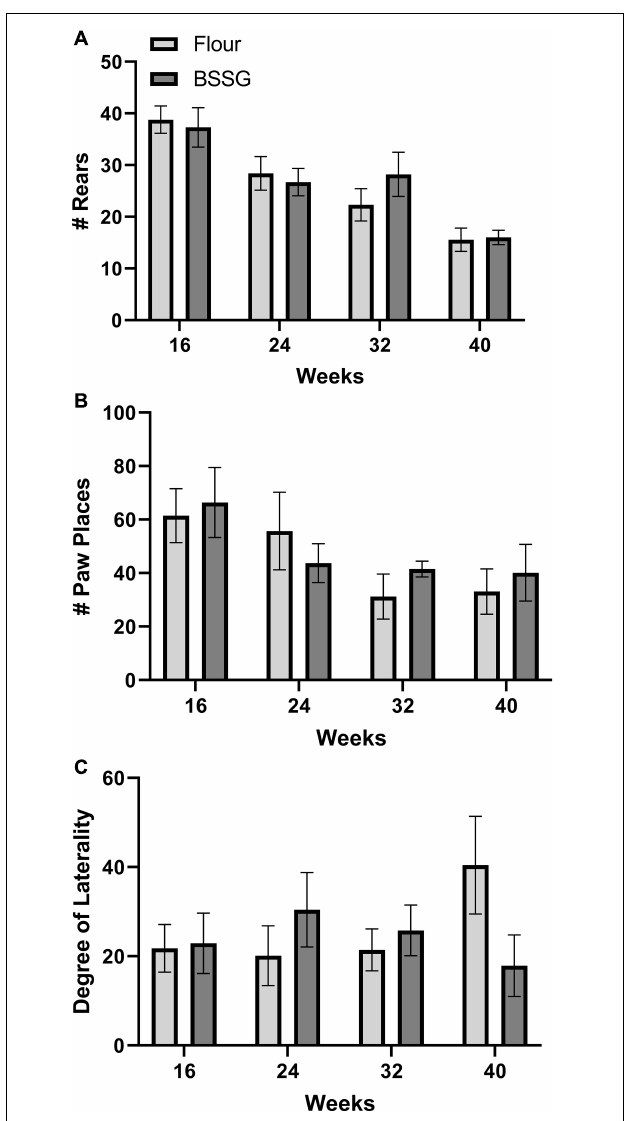
FIGURE 5 | Cylinder test outcomes. (A) Total number of rears. (B) Total number of paw placements. (C) Degree of laterality of paw placements. Data are shown as means ± SEM, n =